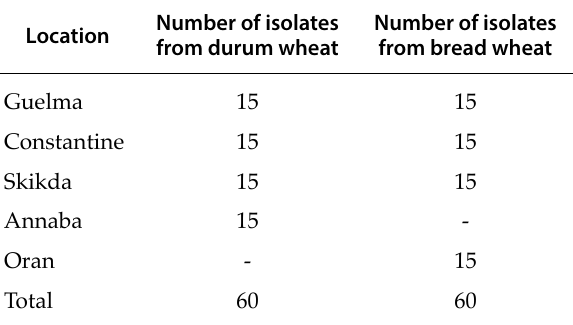
Table 1. Origin and number of Algerian Zymoseptoria tritici isolates used in this